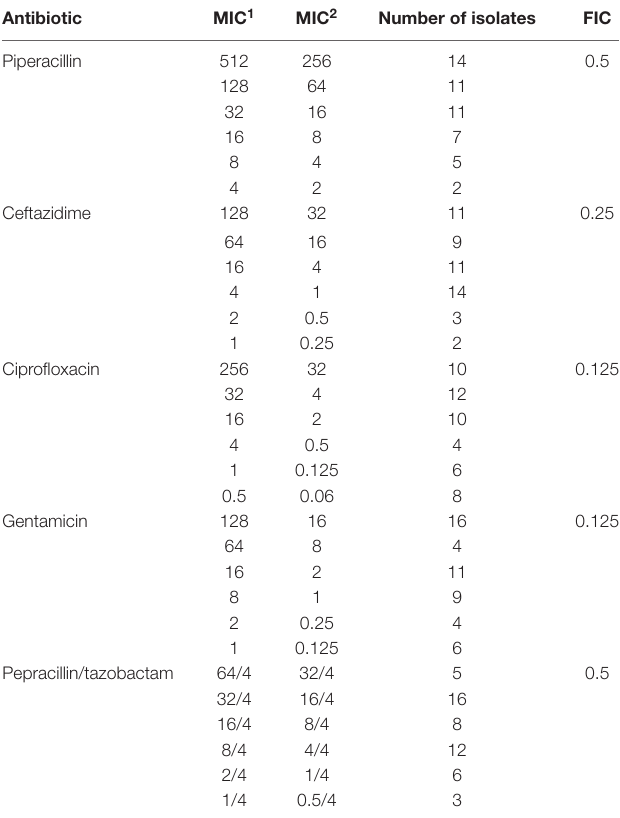
TABLE 2 | The results of ascorbic acid /antimicrobial combinations. Antibiotic